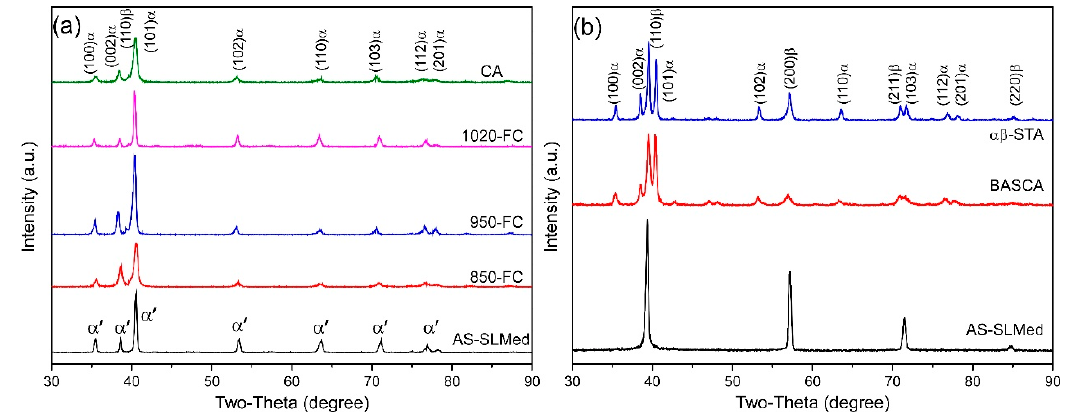
Figure 5. The X-ray diffraction (XRD) spectra of as-fabricated and post-heat treatment samples of ( a ) Ti64 and ( b ) Ti55511.